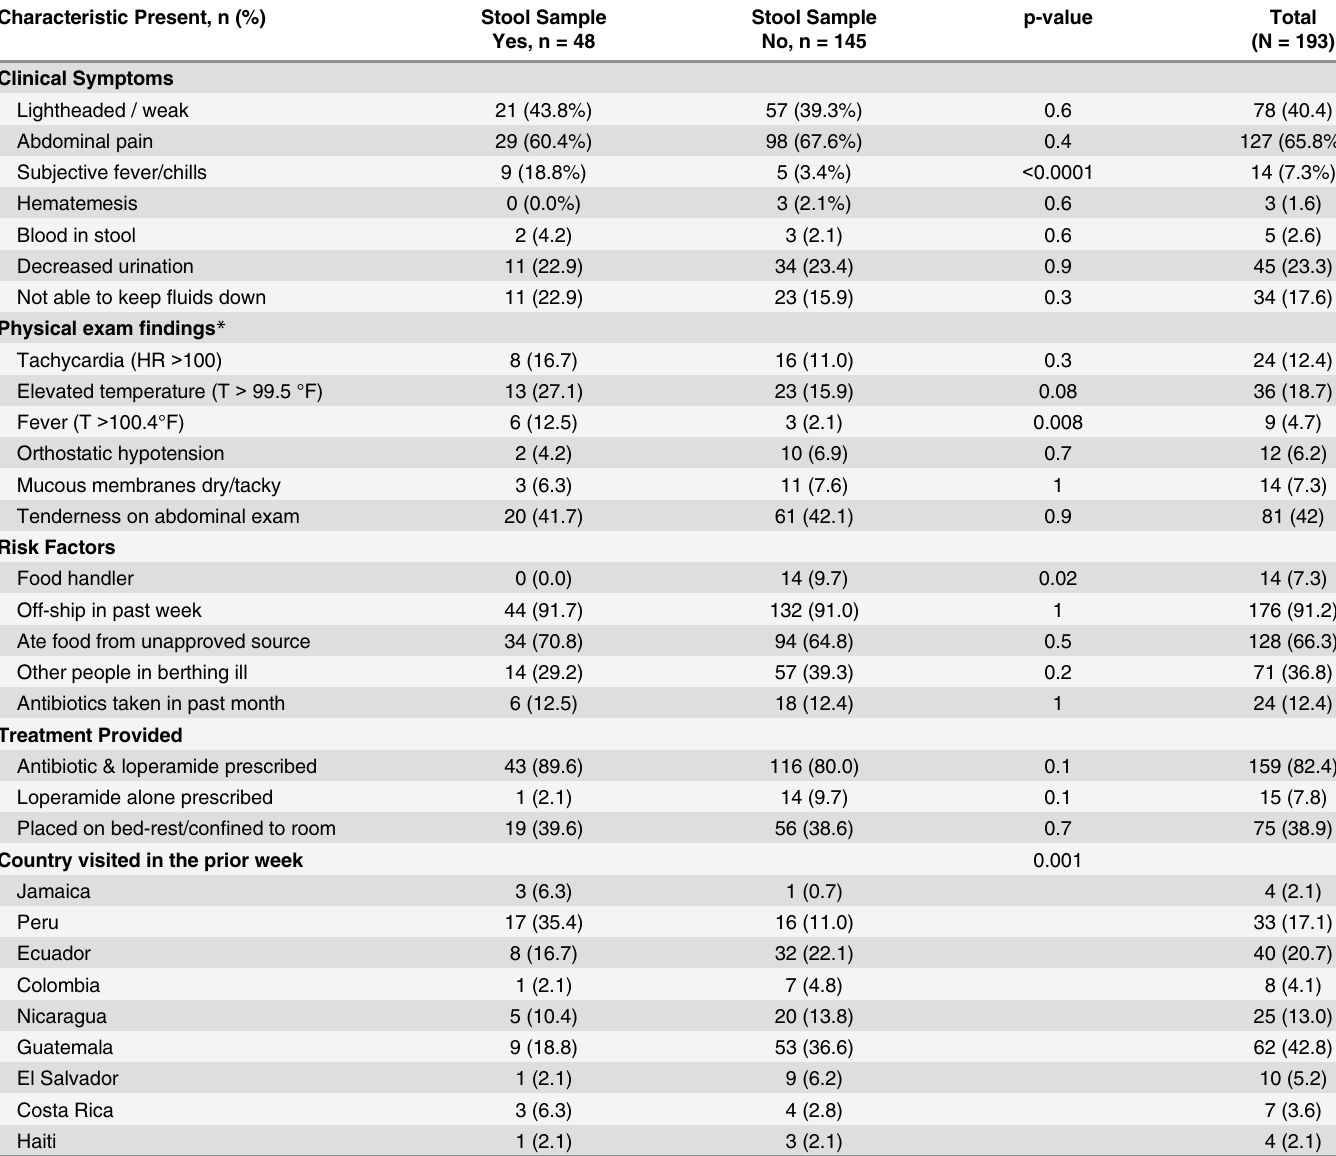
Table 3. Characteristics of the Travelers ’ Diarrhea Cases Seen in the Medical Clinic Stratified by Stool Sample Collection. Characteristic Present, n